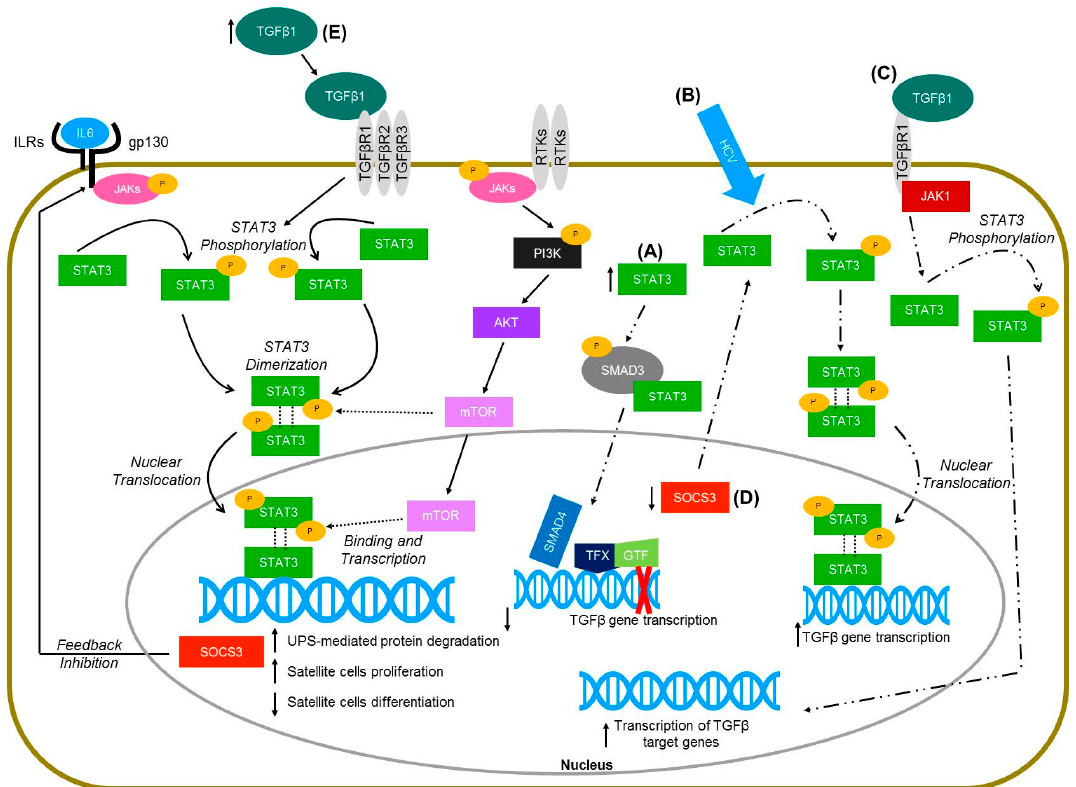
Figure 1. Molecular pathways of STAT3 signaling in skeletal muscle (solid lines) and non-muscle cells (hepatocytes and keratinocytes—dashed lines). ( A ) Increased levels of STAT3 in HaCaT cells lead to the physical interaction of STAT3 with SMAD3, thus inhibiting TGFbeta gene transcription (Wang et al., 2016 [115]). ( B ) Hepatitis C virus infected hetapoma cells have greater activation of STAT3 and subsequent increased TGFbeta gene expression (Presser et al., 2013 [117]). ( C ) TGFbeta activation in hepatic stellate cells leads to janus kinase 1 (JAK1) binding to TGFbeta receptor type 1 (TGF β R1), which leads to the phosphorylation of STAT3 and ultimately the transcription of TGFbeta target genes (Tang et al., 2017 [118]). ( D ) Deletion of the suppressor of cytokine signaling-3 (SOCS3) gene in mice injected with dimethylnitrosamine resulted in increased activation of STAT3 in liver cells, and further increased the expression of TGFbeta 1 (Ogata et al., 2006 [112]). ( E ) TGF- β 1 overexpressing mice have increased levels of pSTAT3 (Guadagnin et al., 2015 [5]).